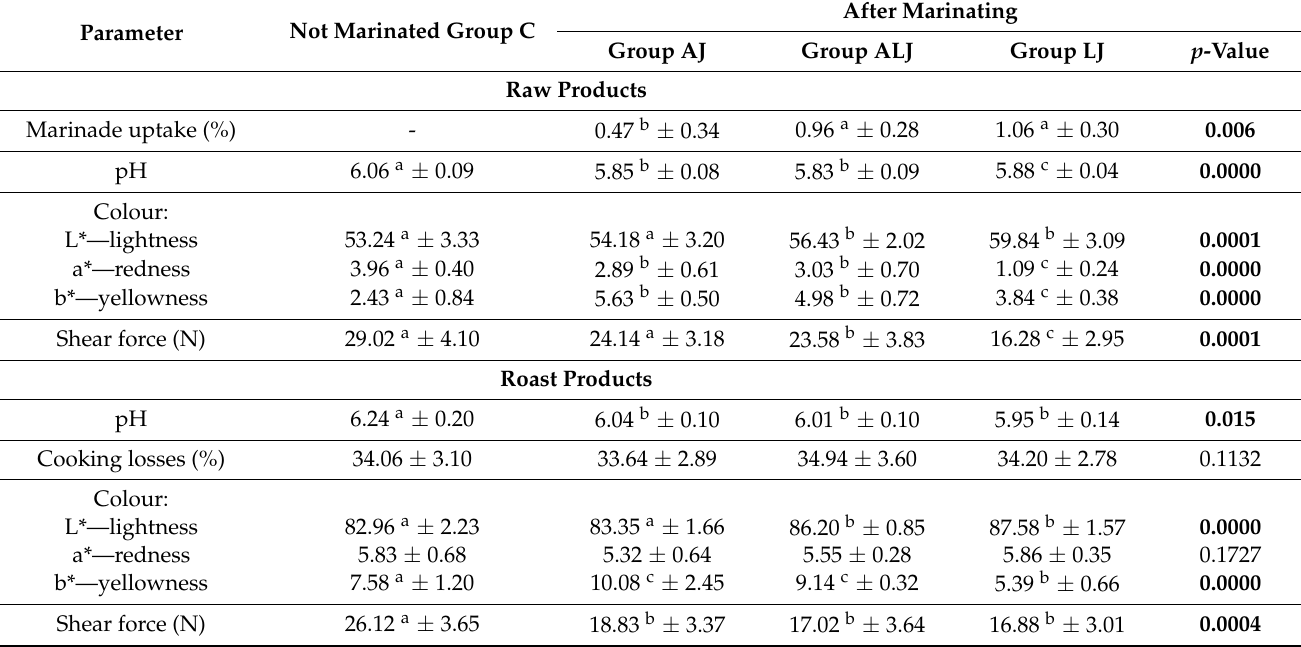
Table 1. Impacts of fruit juice marinating on the technological characteristics of marinated